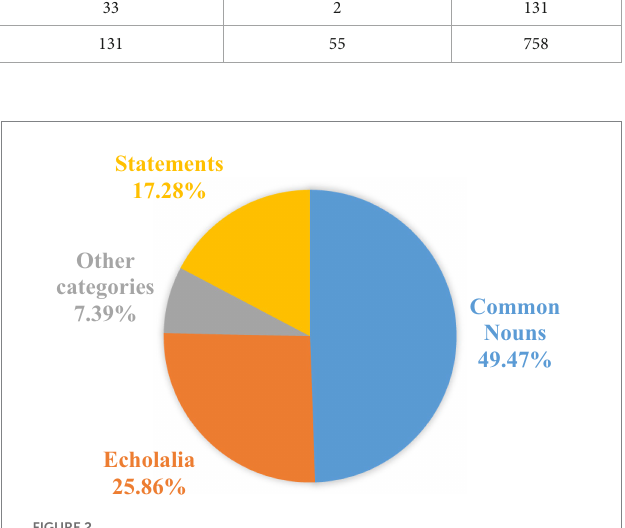
FIGURE 2 Average distribution of the main formal